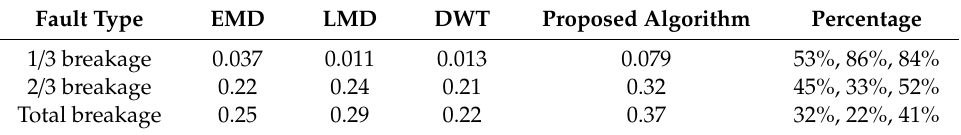
Table 2. Comparison of the first-order frequency amplitude value of di ff erent analysis